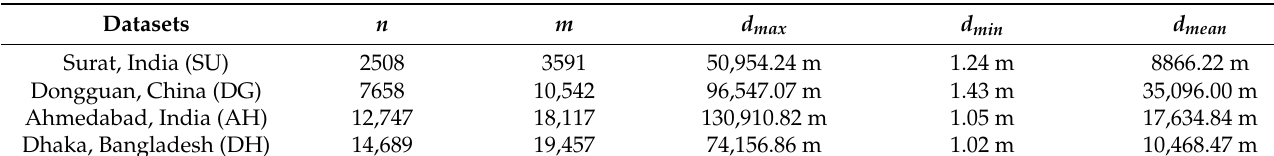
Table 1. Statistics of road network datasets.